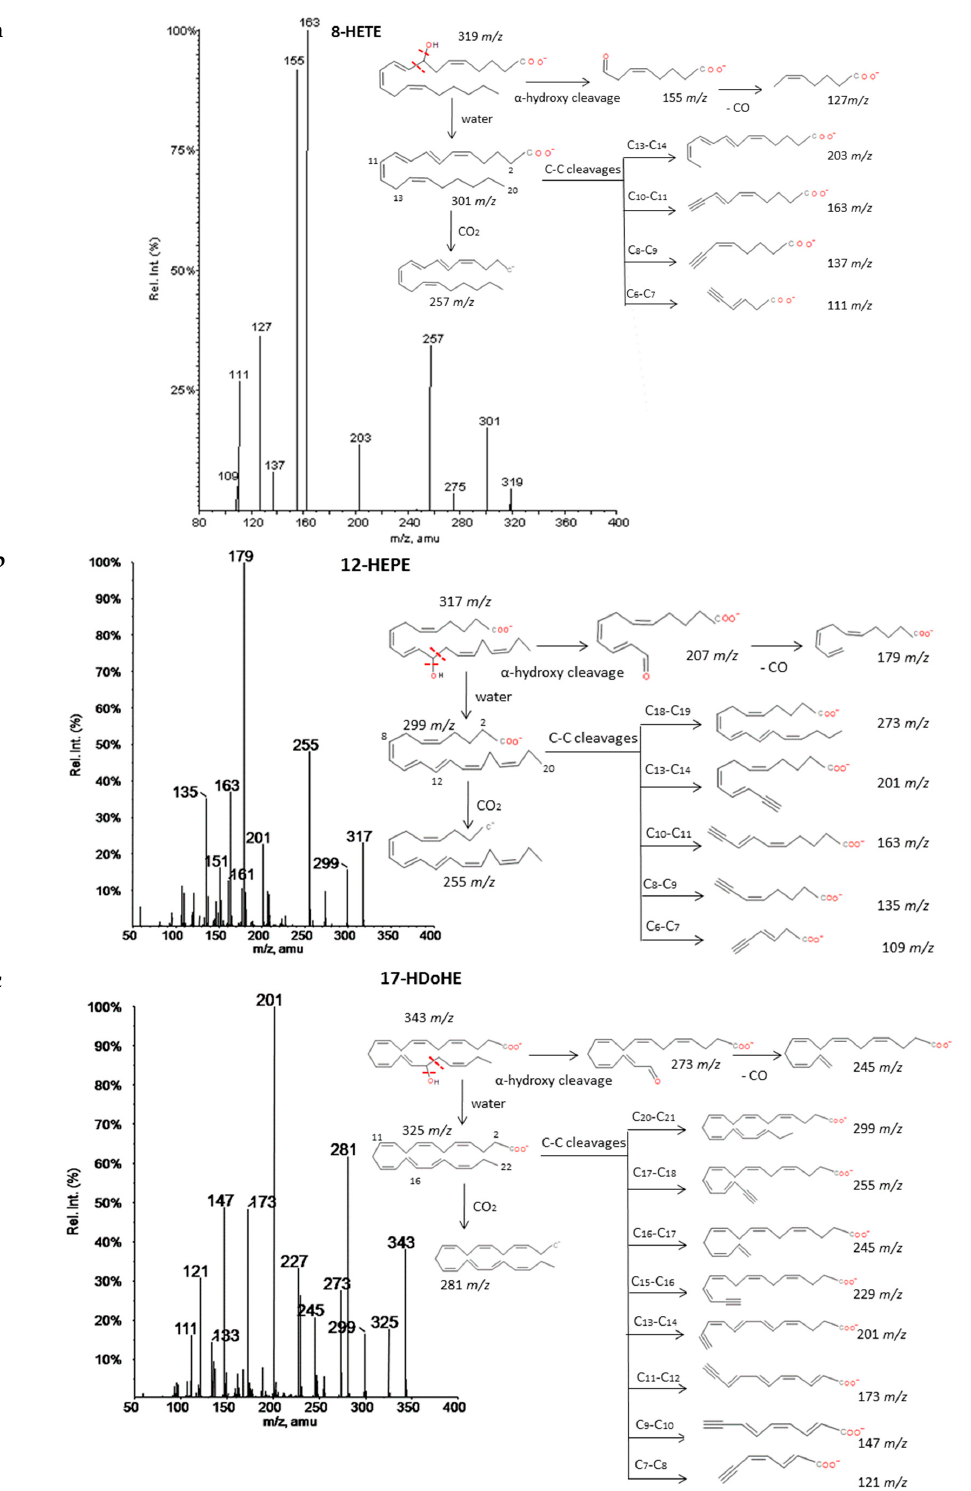
Figure 2. Fragmentation patterns suggested for ( a ) ARA, ( b ) EPA and ( c ) DHA hydroxides. Common cleavages and specific transitions for 8-HETE, 12-HEPE and 17-HDoHE. Product ion spectra at m / z 319 for 8HETE, m / z 317 for 12HEPE, and m / z 343 for 17HDoHE were obtained from the LIPID MAPS database at CID